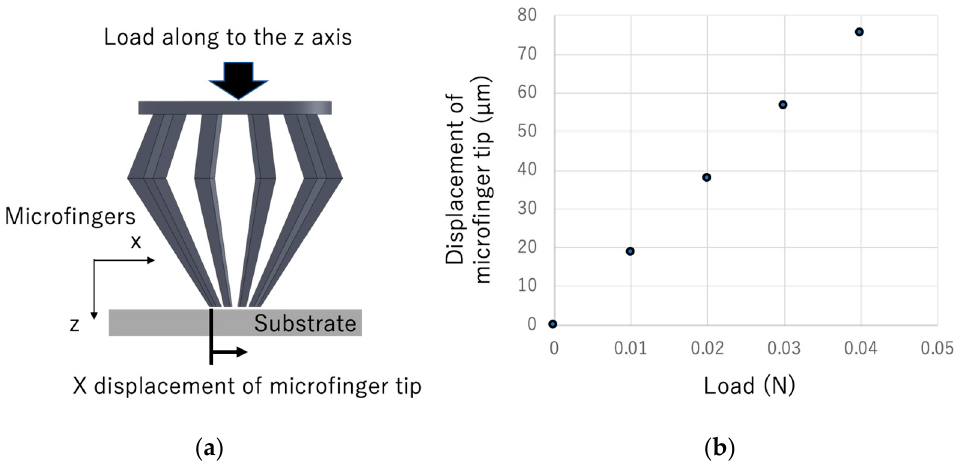
Figure 6. Analysis of x displacement of the microfinger under load: ( a ) Simulation model; ( b ) Displacement of the microfinger along the x axis.